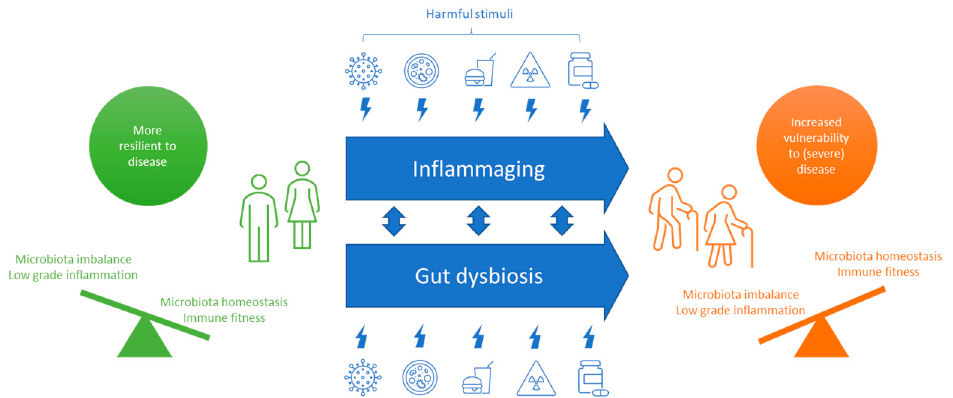
Figure 1. With age, the human body becomes less resilient and more vulnerable to (severe) disease due to inflammaging and gut dysbiosis. In healthy adults the immune system is fit, with the pro- and anti-inflammatory processes in balance, and the beneficial and pathogenic microorganisms in balance. The body is resilient to disease. During aging, the body has to respond to all kinds of harmful stimuli including viruses, pathogenic bacteria, a poor diet, toxins, and drugs, leading to inflammaging and gut dysbiosis; shifting the balance towards higher vulnerability to diseases like COVID-19, heart disease, diabetes, cognitive decline and frailty.